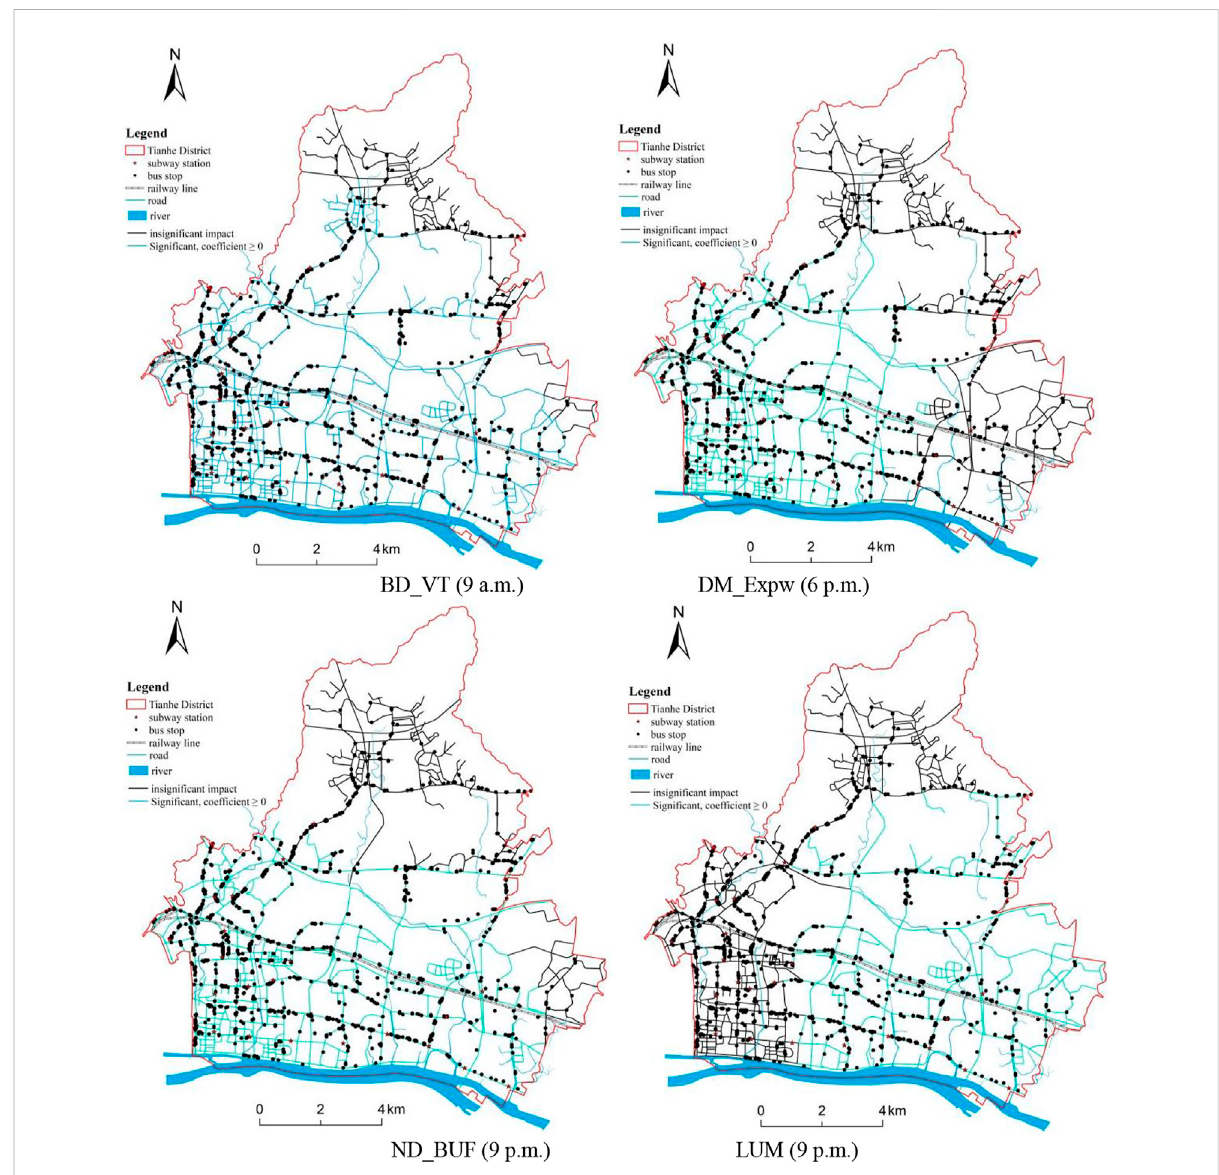
FIGURE 2 Spatio-temporal differentiation pattern of the in fl uence of the built environment on street